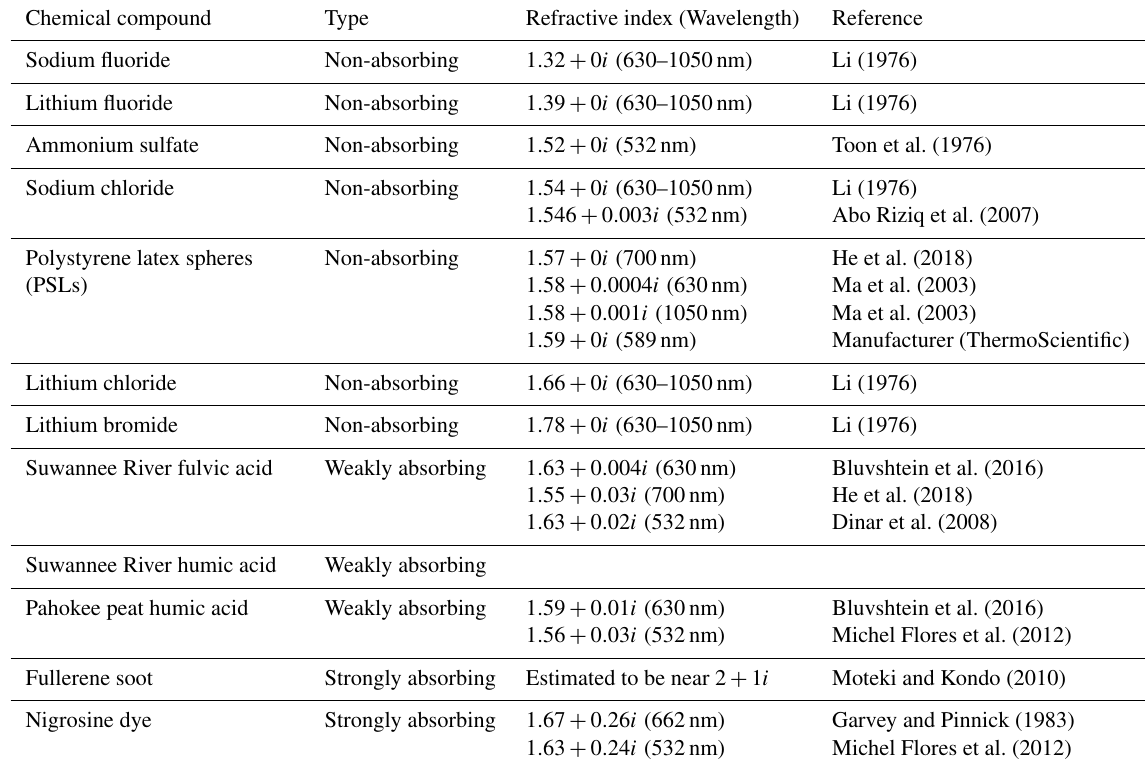
Table 1. Summary of investigated chemical compounds and their refractive indices as reported in the literature. Chemical